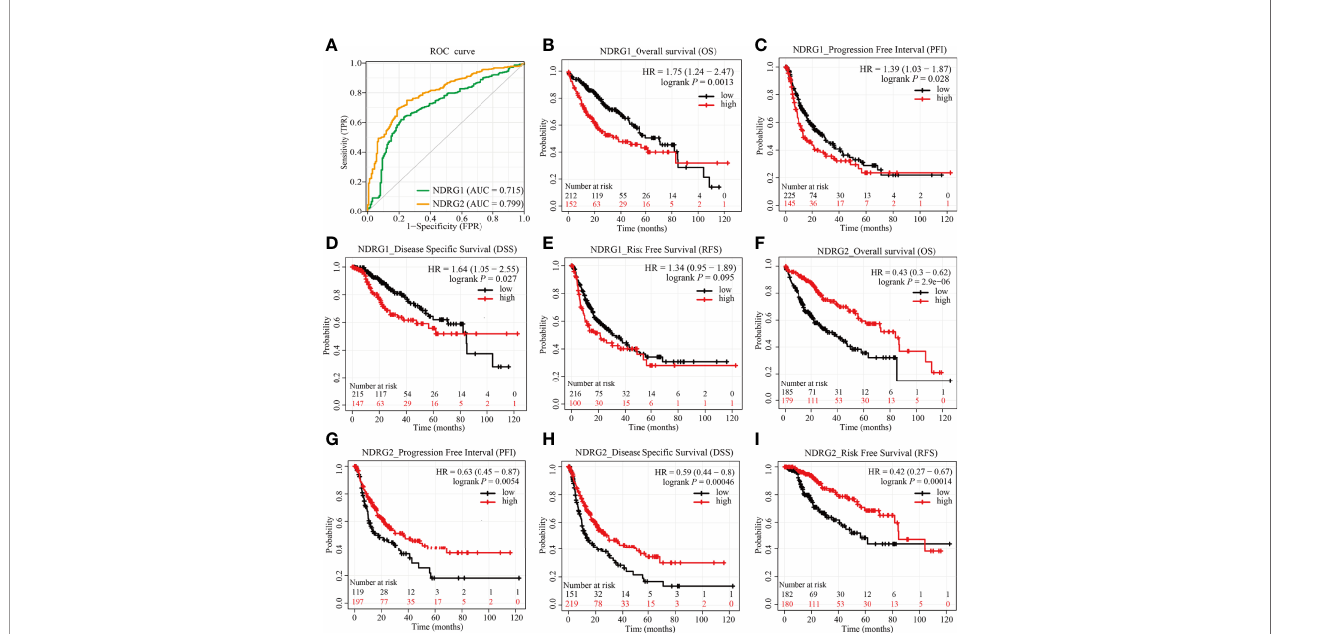
FIGURE 6 | Predictive values of NDRG1 or NDRG2 for diagnosis and prognosis in LIHC. (A) AUROC analysis evaluating the diagnosis performance of NDRG1 or NDRG2 for LIHC between tumor and normal tissue. (B – E) Kaplan – Meier (KM) survival curves comparing NDRG1 -high and -low patients with hepatocellular carcinoma. (F – I) KM survival curves of OS, PFI, DSS, and RFS between high and low expression groups of NDRG2 in LIHC.